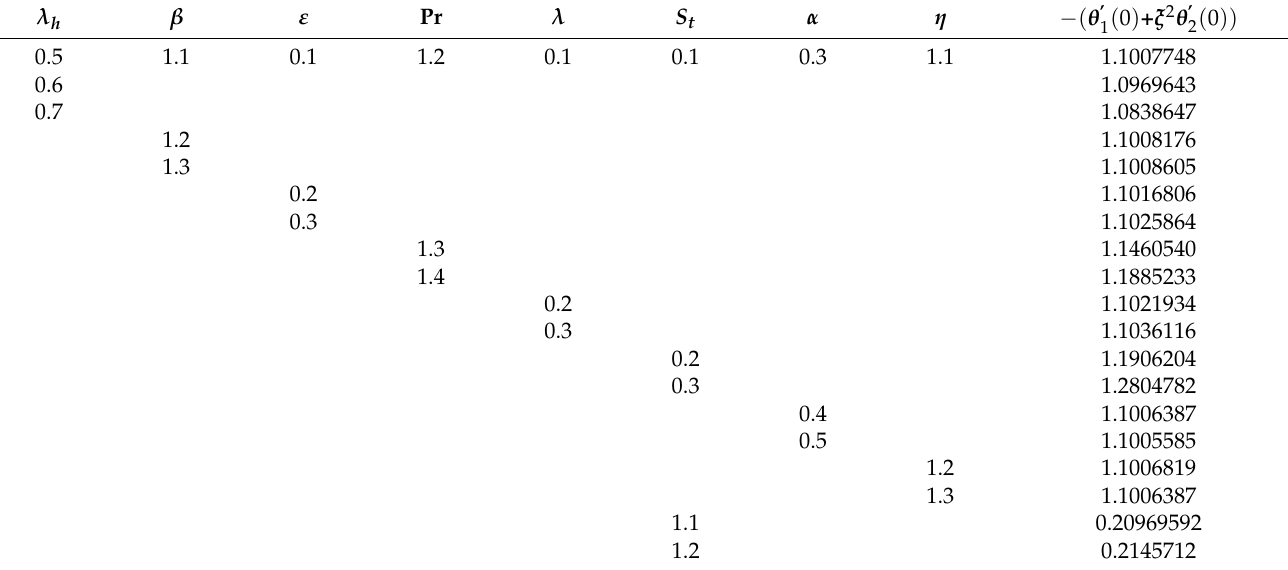
Table 2. Estimation of Nusselt number ( Nu x R ex 1 2 ) for varying parameters λ h , β , ε , Pr, λ , S t , α , η